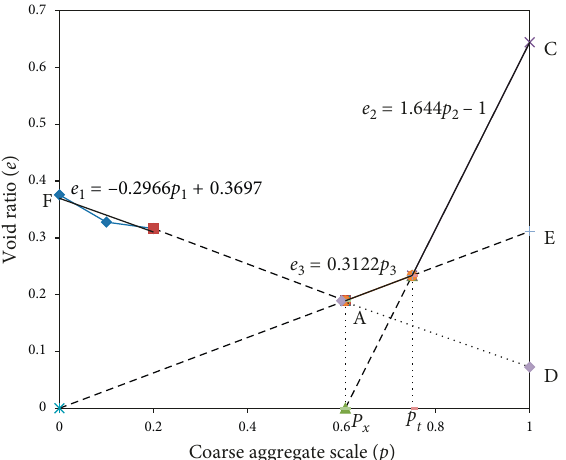
Figure 3: The optimum design process of the two aggregates.